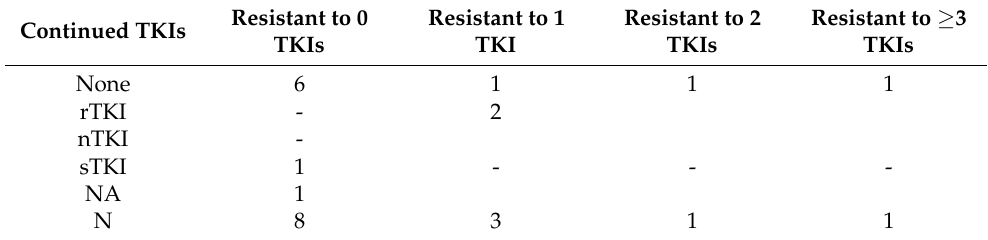
Table 6. Application of TKIs in 13 patients with undefined lesions before and after radiotherapy. Resistant to Continued TKIs